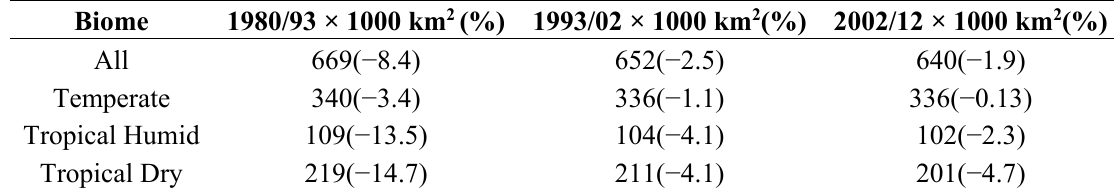
Table 1. Land change 1980–2012. Source: Data from Series de Uso de Suelo y Vegetación I, II, III & V